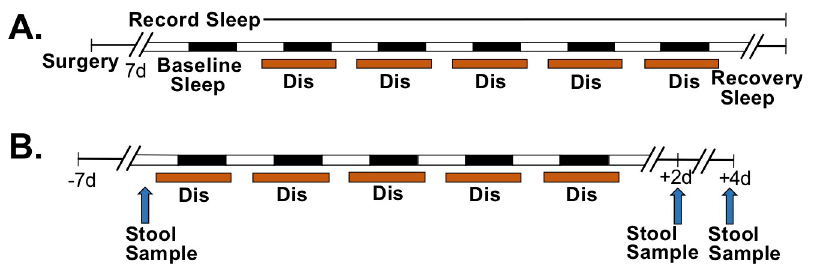
Fig 1. Experimental timelines. A) Experiment 1. Adult male C57BL/6N mice ( n = 3, Control; n = 4, Sleep Disruption) received surgical implants of sleep recording devices. After recovery from surgery, mice were subjected to five days of repeated sleep disruption and two days of ad libitum recovery sleep. Sleep was disrupted for 20 h/day, with an ad libitum sleep window between ZT2-ZT6. Sleep was recorded throughout the experiment. B) Experiment 2. Non- instrumented adult male C57BL/6N mice ( n = 10/group) were subjected to the same sleep disruption protocol, but with four days of recovery sleep. Stool samples were collected before sleep disruption, on day 2 post-sleep disruption and on day 4 post-sleep disruption (arrows). Abbreviations: Dis, Sleep Disruption. control animals, sleep-disrupted animals had significantly less total sleep, NREM sleep, and REM sleep per 24 hours during the protocol ( Fig 2A–2C , F statistics can be found in S1 Table ). While the amount of 24-hour NREM sleep recovered to the level of controls within the first day of recovery sleep ( Fig 2B ), there was a significant rebound in the amount of REM sleep on the first day of recovery sleep ( Fig 2C ). In order to observe sleep with greater resolu- tion, we examined the fifth day of the sleep disruption protocol and the beginning of the first day of recovery sleep using two-hour time bins. It was evident that the majority of this 24-hour sleep loss occurred during the hours of the light period in which the motorized sleep disrup- tion bar was moving (ZT0-ZT2 and ZT6-ZT12, Fig 2E–2G ). REM sleep was reduced to nearly zero percent while the motorized bar was moving, and this resulted in strong REM rebounds during the first two hours of the ad libitum recovery windows ( Fig 2G ). Sleep disruption also resulted in more fragmented sleep. During the five days of sleep disruption, there was a signifi- cantly higher number of state changes in sleep-disrupted mice compared to controls ( Fig 2D and 2H ). Furthermore, there was an increase in the number of bouts of sleep and bouts of NREM in the sleep disruption group, accompanied by a significant decrease in the bout length, further suggesting fragmentation ( S1 Fig ). The number of REM bouts per 24 hours was signifi- cantly decreased on days the motorized bar was on, was significantly increased on the first recovery day, but no longer significantly different from control by the second recovery day ( S1 Fig ). Five days of sleep disruption creates changes in the fecal microbiome that last at least four days after disruption has ended In Experiment 2, fecal samples were collected before sleep disruption (BL), at day two post- sleep disruption (R2), and at day four post-sleep disruption (R4) (see Methods and Fig 1B ) to assess the fecal microbiome and fecal metabolome. Beta diversity, or the difference in diversity between two or more communities, was assessed at each experimental time point with weighted UniFrac distance, which takes into account both the abundances and phylogenetic relatedness of two communities[39, 50]. Principal coordinates analysis (PCoA) revealed no difference between control and sleep-disrupted groups at baseline, as expected ( p = 0.877, PERMANOVA; Fig 3A ), but significant clustering of control mice and sleep-disrupted mice indicated a global difference in community structure at R2 ( p = 0.018, PERMANOVA; Fig 3B ) that was gone by R4 ( p = 0.663, PERMANOVA; Fig 3C ). The distance from baseline, the aver- age weighted UniFrac distance between an individual post-sleep disruption and all individuals